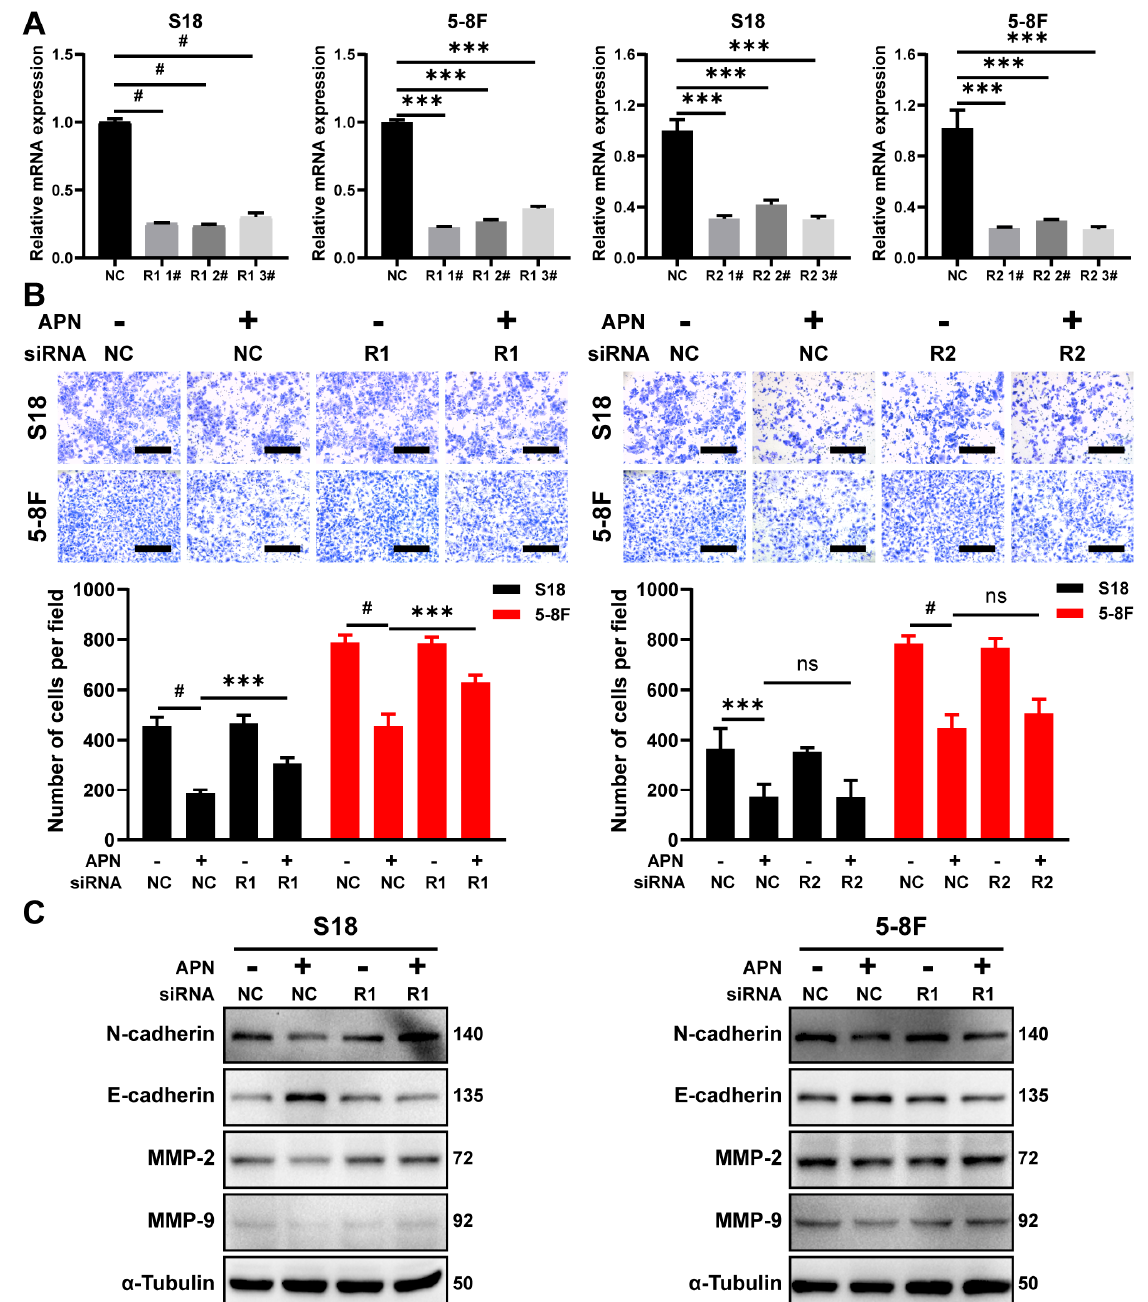
Figure 5. AdipoR1 mediates the metastasis inhibitory effect of adiponectin in NPC cells. ( A ) The mRNA expression of AdipoR1 and AdipoR2 was measured with qRT-PCR in S18 and 5-8F cells after transfected with AdipoR1 or AdipoR2 siRNA. ( B ) Transwell migration assay in S18 and 5-8F cells treated with 40 μ g/mL adiponectin for 24 h after transfected with AdipoR1 or AdipoR2 siRNA. Scale bar: 200 μ m. Graphs show the relative number of migration cells. ( C ) Western blot analysis of E-cadherin, N-cadherin, MMP-9, and MMP-2 in S18 and 5-8F cells treated with 40 μ g/mL adiponectin for 48 h after transfected with AdipoR1 siRNA. Results are presented as mean ± SD of three independent experiments performed in triplicate. *** p < 0.001, # p < 0.0001.